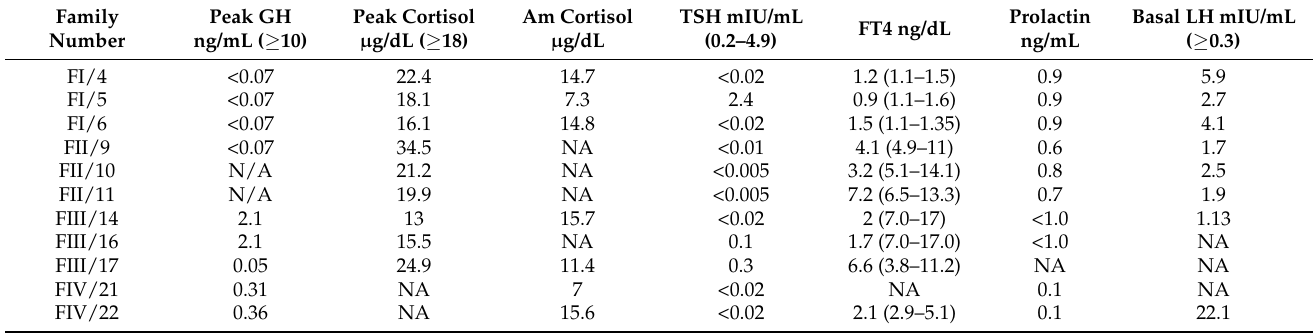
Table 2. Selected hormonal values in patients with CPHD: NA, not available; GH, growth hormone; TSH, thyroid-stimulating hormone; LH, luteinising hormone; FT4, thyroxine.